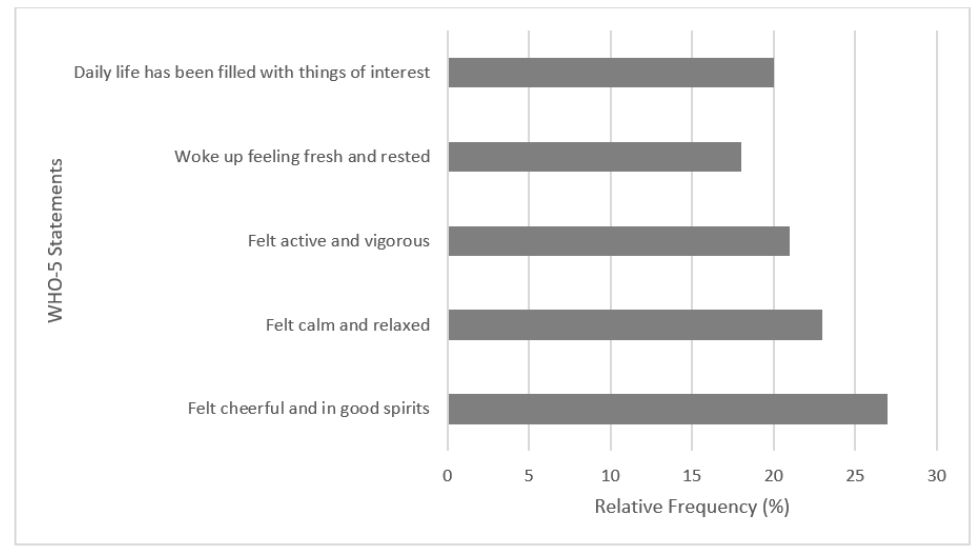
Figure 5. Percentage of participants who described feeling the above statements, ‘all of the time’ or ‘most of the time’, within the last 2 -weeks.